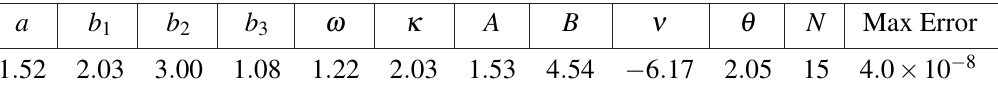
Table 1. Parameters for model (1) corresponding to example 1